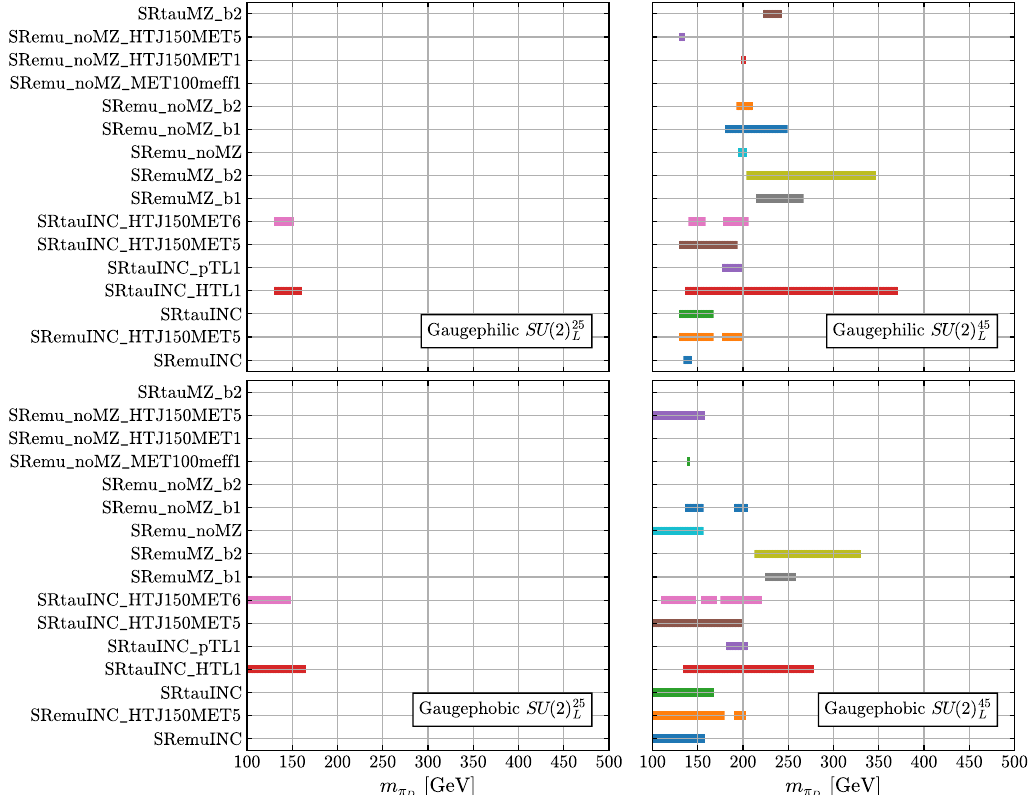
Figure 10 . Out of the 144 signal regions defined in ref. [148], 16 regions constrain some portion of the dark meson parameter space. The mass ranges which are colored are excluded. The gaugephilic models have larger branching ratios to Zh and Wh than the gaugephobic models, which leads to greater search efficiency and larger